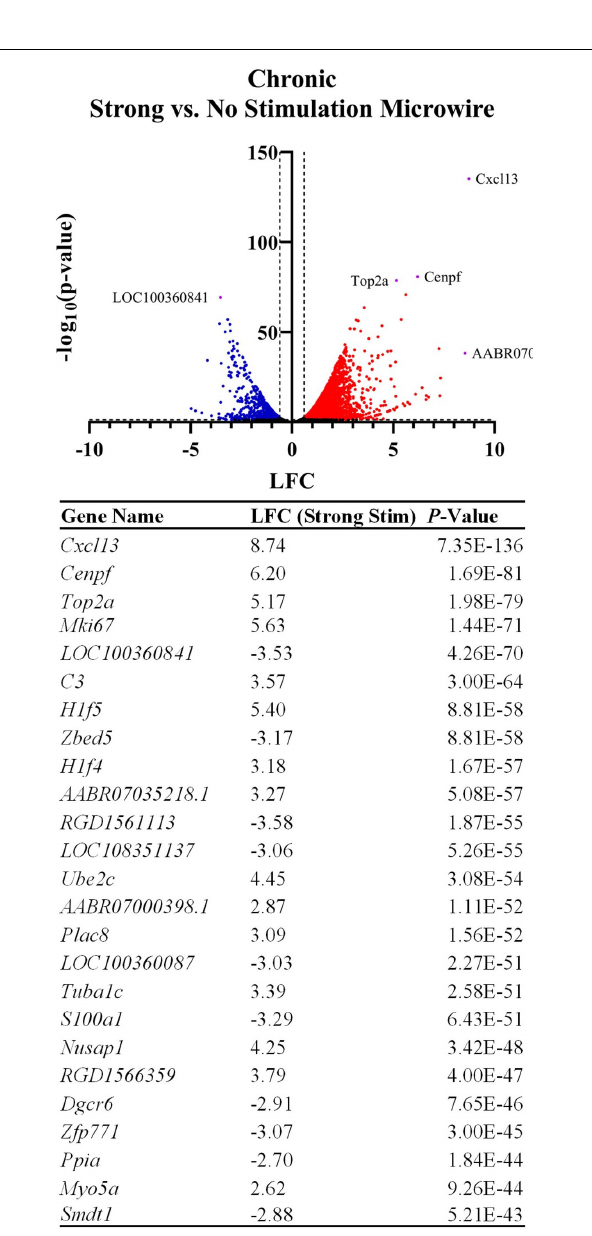
FIGURE 8 | Stimulation influences the expression of thousands of genes following chronic implantation. The volcano plot and table show differentially expressed genes between an MWA delivering a strong electrical stimulation vs. no stimulation (LFCs indicate differentially expressed genes in strong stimulation relative to no stimulation). Similarly to the MWA vs. HDCF strong stimulation comparison, inflammation-associated genes were upregulated by the MWA delivering stimulation. However, the associated LFCs were relatively more pronounced when referenced to the MWA non-stimulated sample (for example, Cxcl13 shows a LFC = 8.74, vs. LFC = 6.16 in Figure 6 ). The table shows the top 25 most significant DE